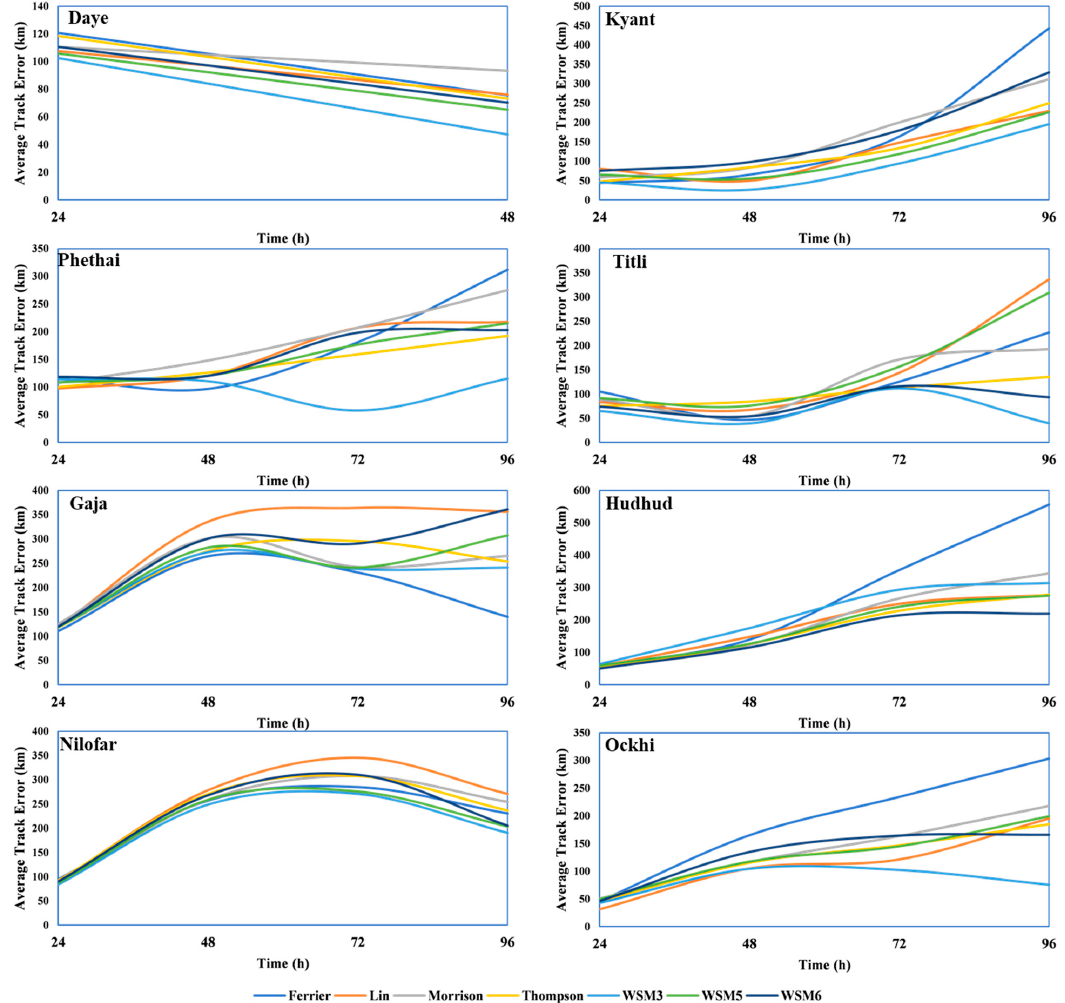
Figure 6. Average track error at every 24-hour interval of the tropical cyclones considered. The Mean Absolute Error (MAE) and Mean Square Error (MSE) of MSW for all CMPs were calculated and the results of the TC Hudhud are presented in Figure 7. In the case of Nilofar, Kyant, Daye, and Phethai cyclones, WSM3 indicates the lowest MAE and MSE. The lowest MAE for the TCs ranged from 4.73 to 17.08 m / s, 6.84 to 4.63 m / s, 8.60 to 1.45 m / s, and 7.16 to 3.66 m / s for MSW from 24 h to the end of the simulation. The lowest MSE for the TCs ranged from 10.14 to 11.31 m 2 / s 2 , 2.89 to 4.97 m 2 / s 2 , 6.56 to 0.88 m 2 / s 2 , and 2.29 to 6.29 m 2 / s 2 . The lowest MAE and MSE for the Gaja cyclone were obtained from the Ferrier scheme and are ranged from 4.19 to 9.94 m / s and 5.77 to 13.46 m 2 / s 2 , respectively. However, for the Hudhud, Titli and Ockhi cyclones, the WSM6 and Lin scheme provided the lowest MAE, ranging from 2.44 to 9.49 m / s, 5.08 to 3.91 m / s and 4.85 to 3.85 m / s, and the MSE ranged from 1.60 to 1.48 m 2 / s 2 , 5.39 to 8.63 m 2 / s 2 and 6.44 to 12.45 m 2 / s 2 . The schemes which predicted the MSW well also predicted MSLP for the respective